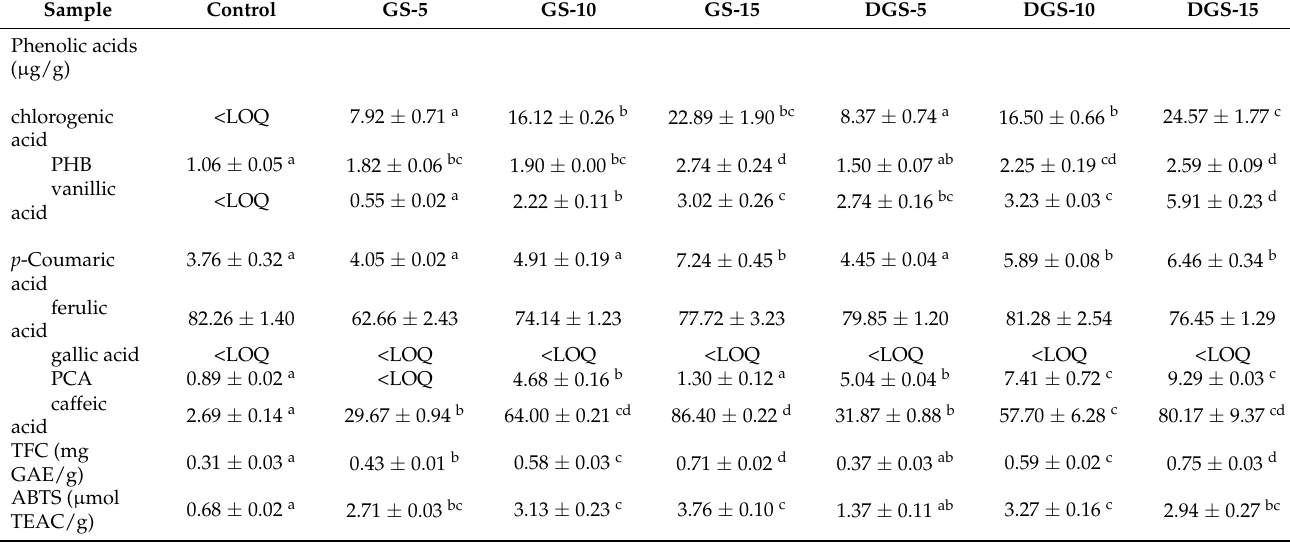
Table 5. Phenolic content and antioxidant properties of biscuits with or without chia